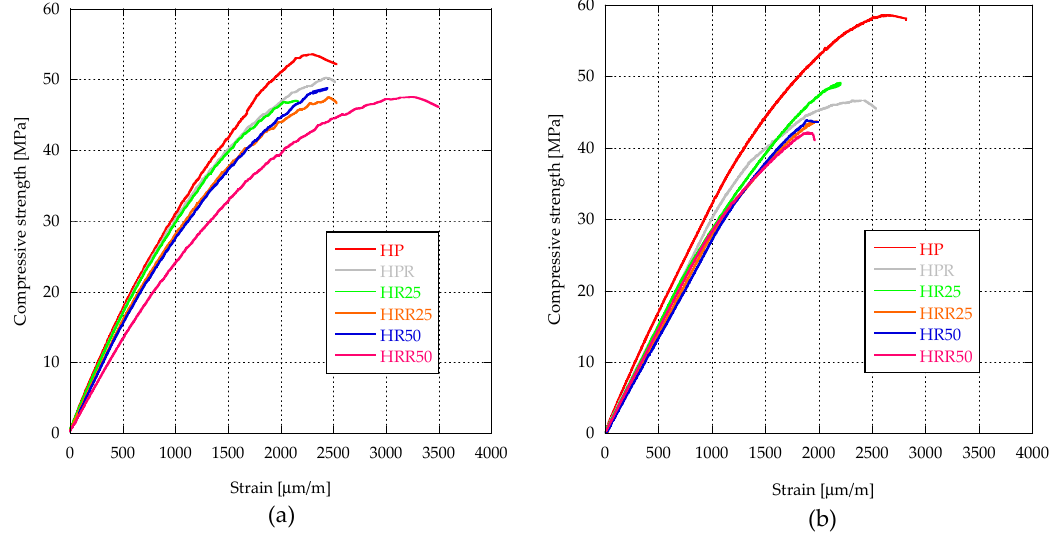
Figure 6. Compressive strength-strain at 160 ( a ) and 365 ( b ) days.